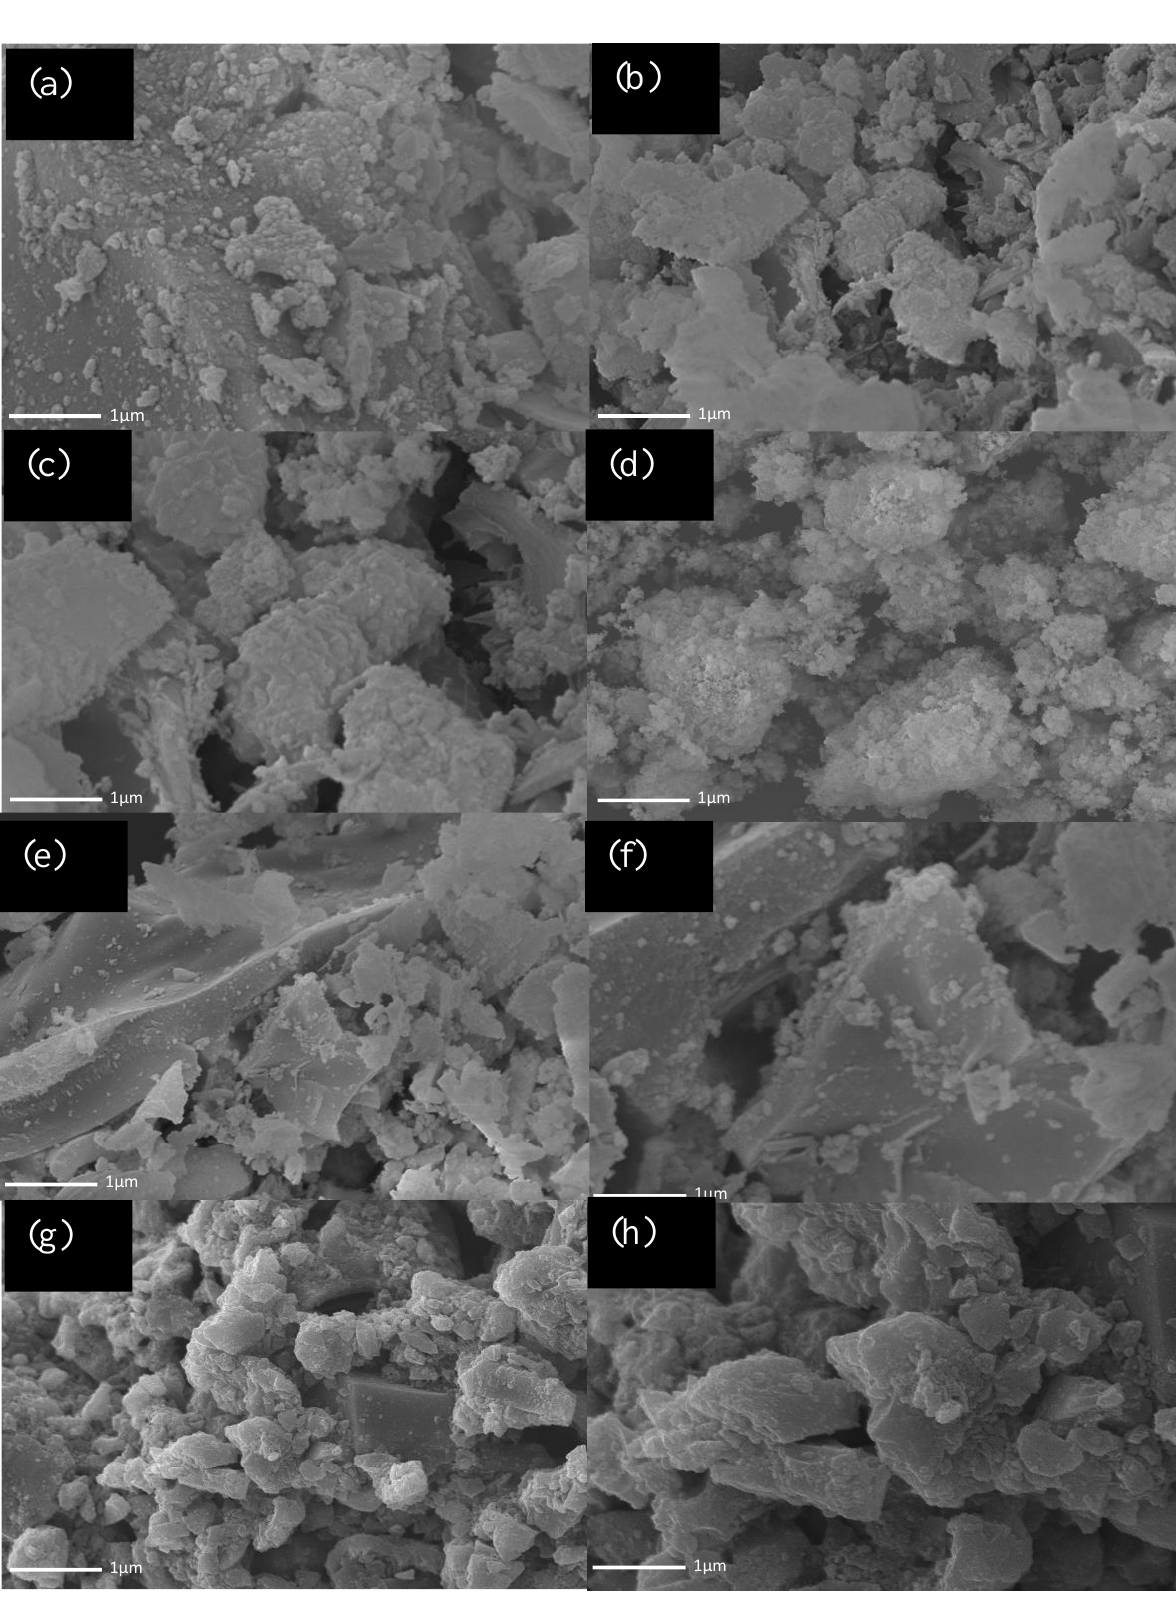
Figure 2. Field emission scanning electron microscopy (FESEM) images of ( a ) SiO 2 , ( b ) Cu 2 S (8%) /SiO 2 , ( c ) Cu 2 S (8%) -FeS (2%) /SiO 2 , ( d ) Cu 2 S (8%) -FeS (5%) /SiO 2 , ( e ) Cu 2 S (8%) -FeS (8%) /SiO 2 , ( f ) Cu 2 S (8%) -FeS (10%) /SiO 2 , ( g ) Cu 2 S (8%) -FeS (12%) /SiO 2 , and ( h ) Cu 2 S (8%) -FeS (15%) /SiO 2. TPD-NH 3 analysis provided data on the acid density and strength of the empirical SiO 2 , Cu/SiO 2 , Fe/SiO 2 , CuS/SiO 2 , and CuS-FeS/SiO 2 catalysts; the respective acid profiles are presented in Figure 3 and Table 1. Weak and medium acidities, i.e., T max > 250 °C and T max > 500 °C, were associated with each catalyst [34 – 36]. At the lower temperature, the synthesised silica exhibited a triad of desorption zeniths, i.e., 163 °C, 512 °C, and 730 °C,